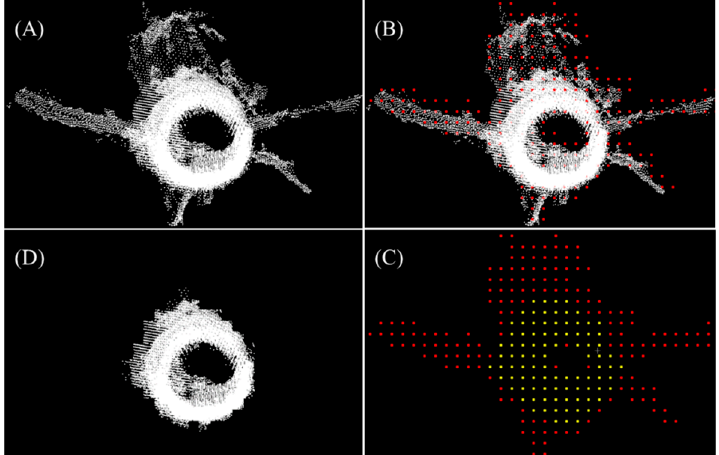
Figure 8. Illustration of the refinement step. ( A ) The points of an extracted stem were vertically projected. ( B ) Then, the projected points were rasterized. The red points indicate the northeast corner of the grid cells. ( C ) The points belonging to each grid cell were automatically counted. The grid cells with an NoP larger than the threshold were labeled as stem cells, which were indicated by the yellow points here. ( D ) The points remaining after the refinement.